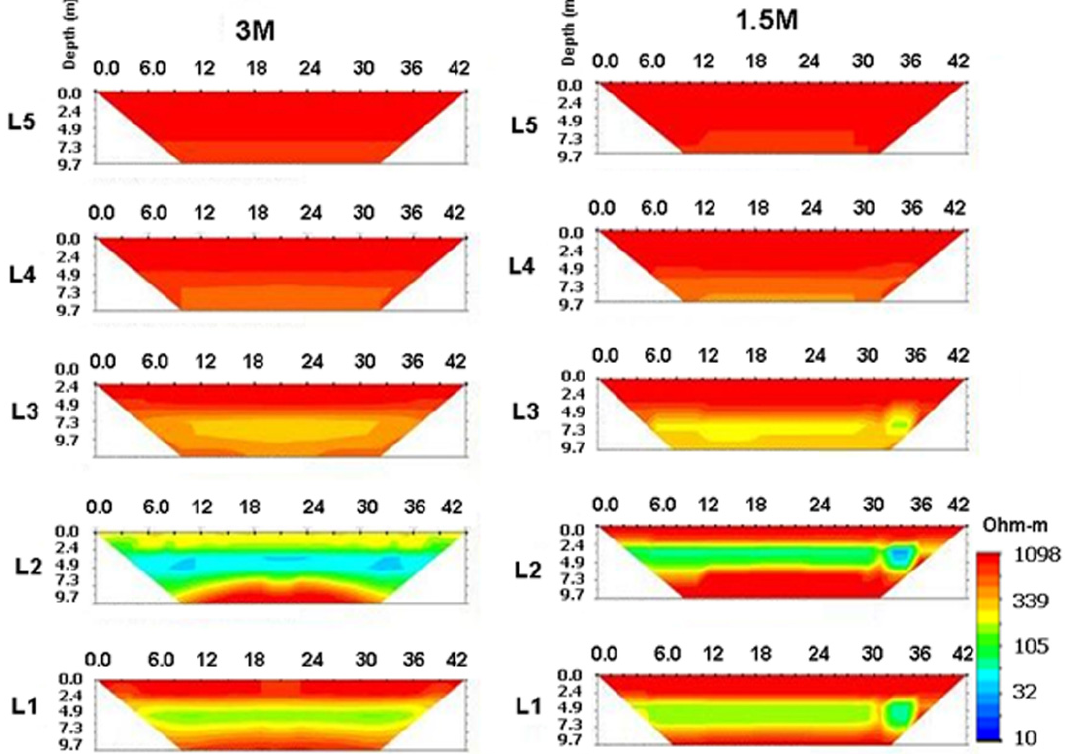
Figure 8. Pipeline stratum model showing the influence between the 3D effect range and electrode spacing.